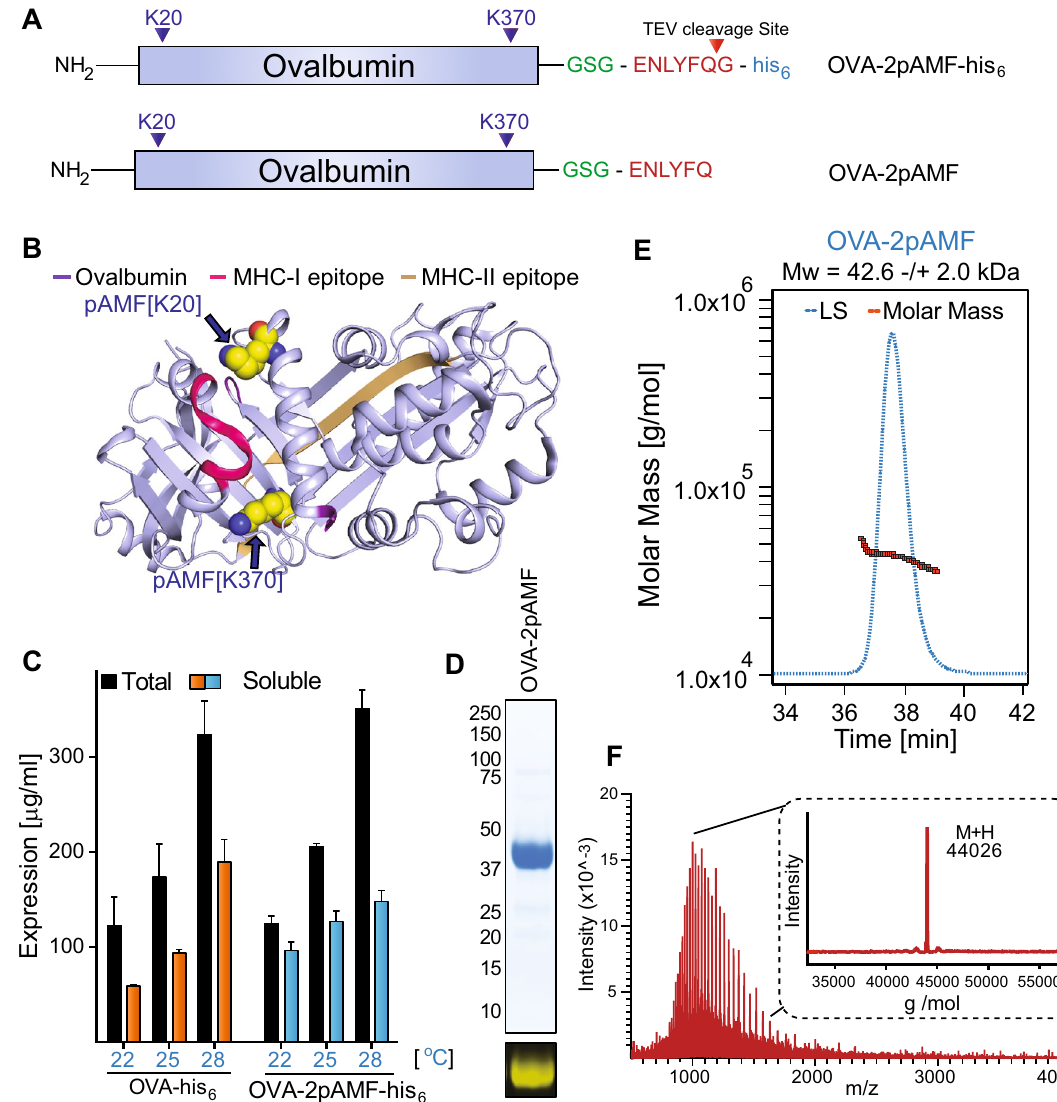
Figure 1. Expression, purification, and characterization of OVA-2pAMF. ( A ) Modular architecture and expression construct design of OVA-2pAMF with ( B ) the K20 and K370 pAMF conjugation sites noted. ( C ) Optimization of OVA-2pAMF expression conditions. ( D ) SDS-PAGE demonstrates > 95% purity, and DBCO- TAMRA labeling confirms pAMF incorporation. Biophysical characterization of purified OVA-2pAMF using ( E ) SEC-MALS indicates a monodisperse protein preparation and F) Q-TOF ESI–MS (deconvoluted in inset) indicates close agreement with the expected mass, 44,026